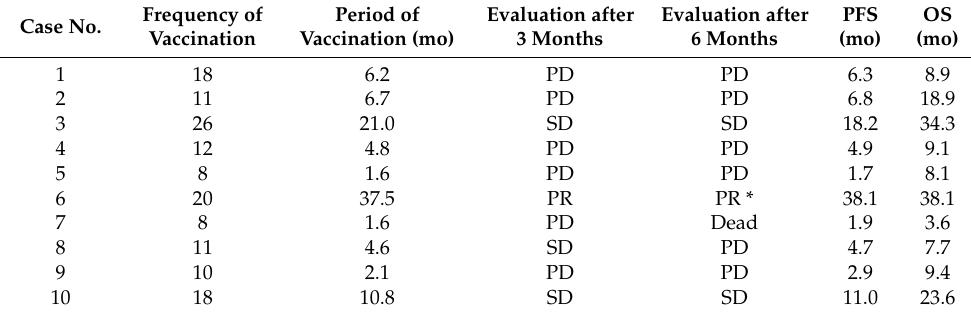
Table 3. Clinical results of 10 enrolled patients.